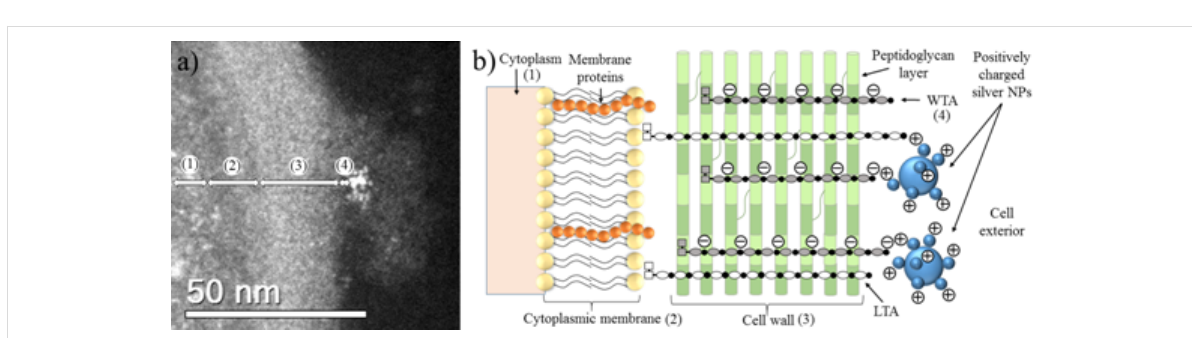
Figure 5: STEM micrograph of cell envelope of MSSA treated with AgNPs. (1) Cytoplasm, (2) cytoplasmic membrane, (3) cell wall and (4) wall teichoic acids. (b) Schematic diagram of our hypothesis on the interaction between AgNPs and the teichoic acids of the cell wall. (WTA = wall teichoic acids; LTA = lipoteichoic acids). The AgNP concentration is 11.5 ppm.